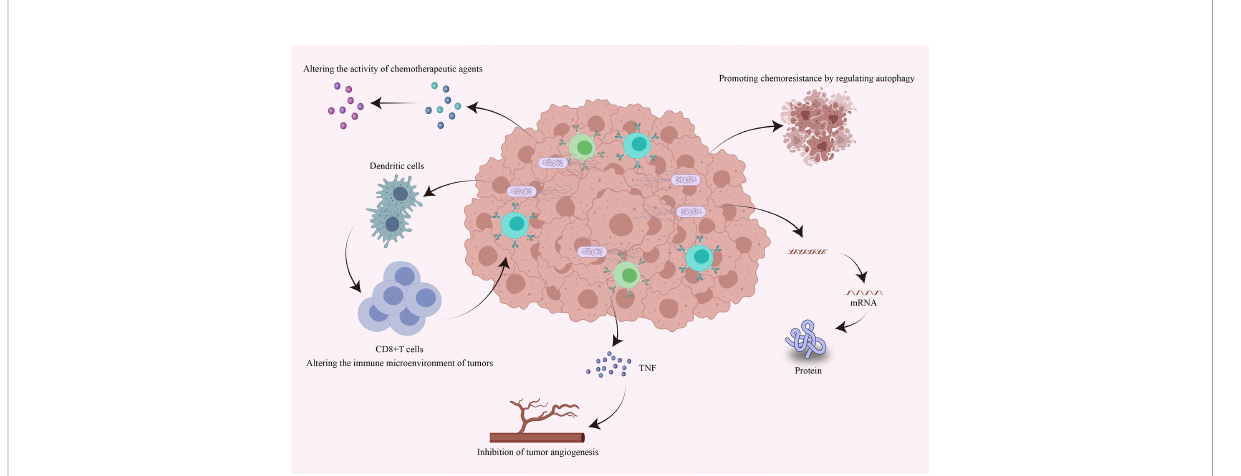
FIGURE 3 Effects of intratumoral bacteria on tumor chemotherapy and immunotherapy response. Intratumoral bacteria can directly or indirectly in fl uence the ef fi cacy of chemotherapy and immunotherapy through multiple mechanisms. Bacteria accumulating within tumors can directly alter the bioactivity of chemotherapeutic drugs and can promote chemoresistance by regulating autophagy. They can also regulate the expression of speci fi c genes by affecting host signaling pathways. Intratumoral bacteria can promote the production of tumor necrosis factor and thus inhibit tumor angiogenesis. Furthermore, intratumoral bacteria can promote the accumulation of immune cells, thereby enhancing antitumor immune responses and the ef fi cacy of